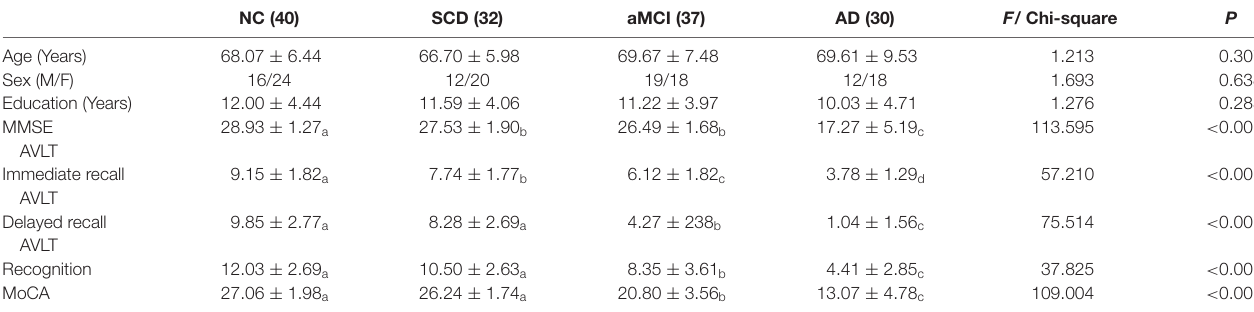
TABLE 1 | Demographic information and behavioral measurements.